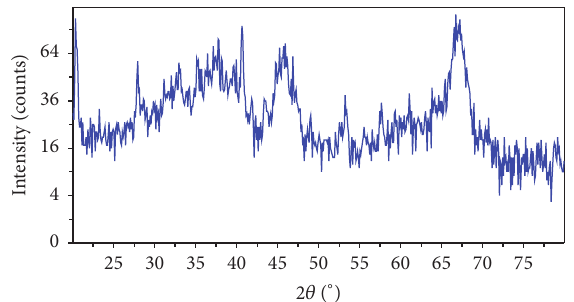
Figure 6: X-ray diffractogram of nanocrystalline 𝛾 -alumina.